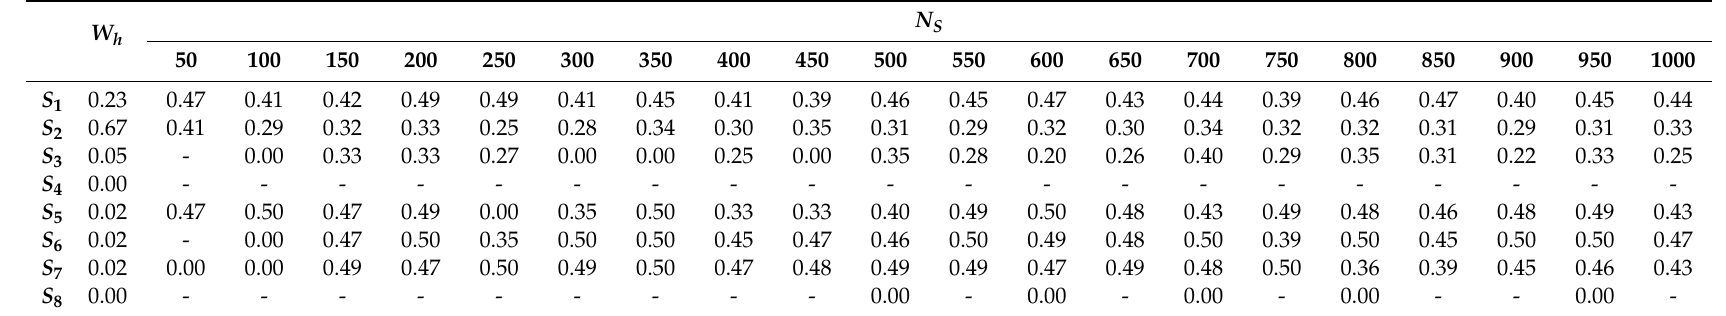
Table 2. Parameter values from watershed unit Number